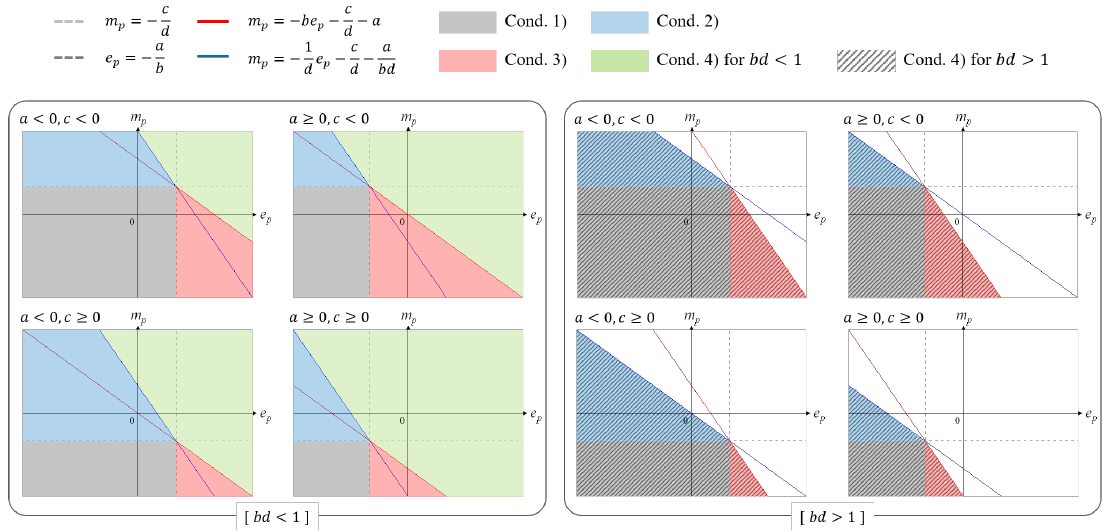
Figure 6. Graphical representation of the region where the solution exists in each case.